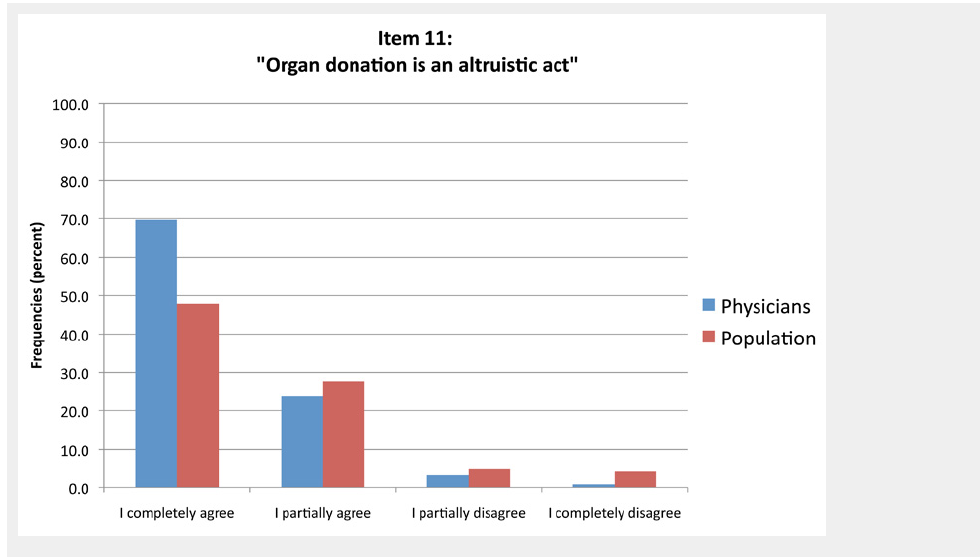
Figure 5 Distribution of the physicians’ and inhabitants’ answers for item 11.